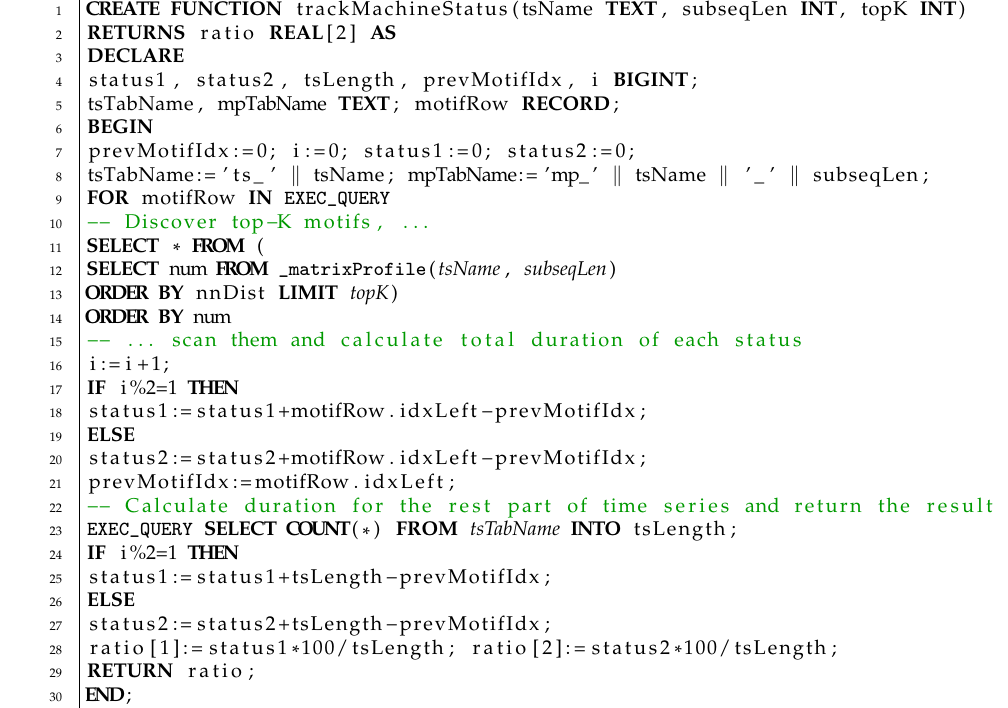
Figure 19. Implementation of the machine operational status tracking case in